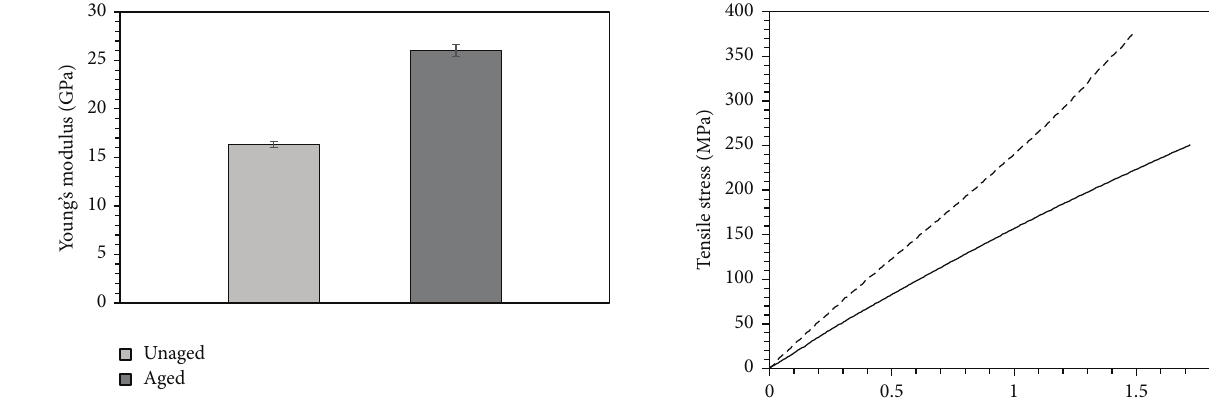
Figure 2: Change in Young’s modulus of EHG250-68-37 composite specimens subjected to 800 h oxidative aging at 82 ∘ C.